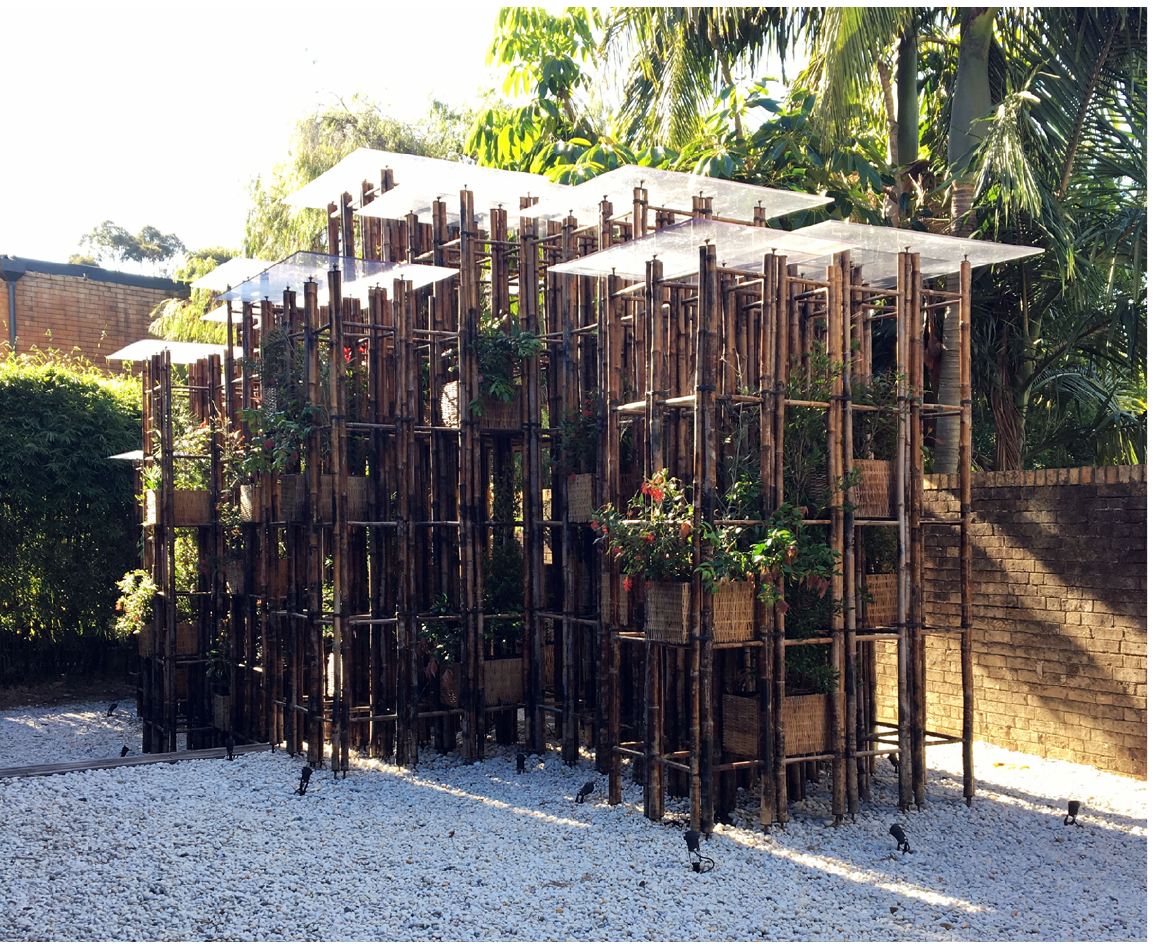
Vo Trong Nghia Architects, 2016 Fugitive Structures project, Green Ladder, Sherman Contemporary Art Foundation (SCAF), Sydney. Source: Photograph by Ashley Paine,